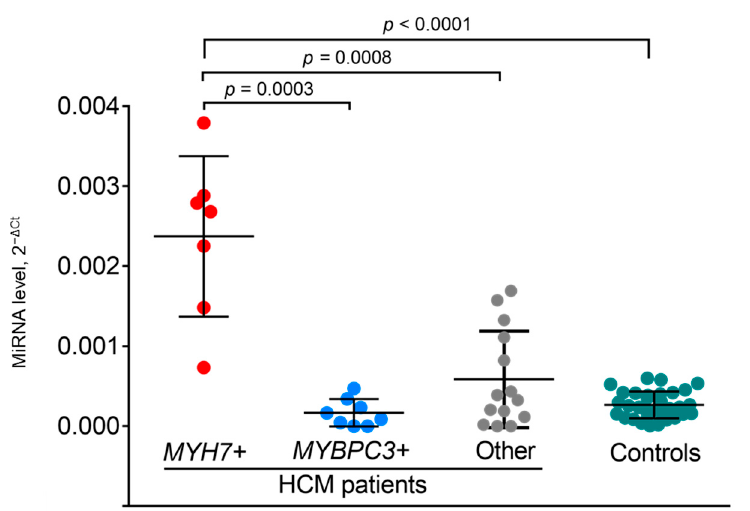
Figure 4. Levels of miR-499a-5p in carriers of mutations in MYH7 gene ( n = 7), in carriers of mutations in MYBPC3 gene ( n = 8), in mixed group of non- MYH7 and non- MYBPC3 mutations carriers and of genotype-negative patients ( n = 14); and controls ( n = 32) as determined by RT-qPCR. Significant differences were determined by using a Mann-Whitney U test.